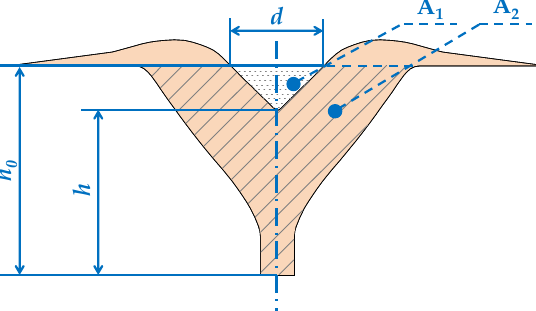
Figure 5. Schematic diagram of furrow contour section parameters.